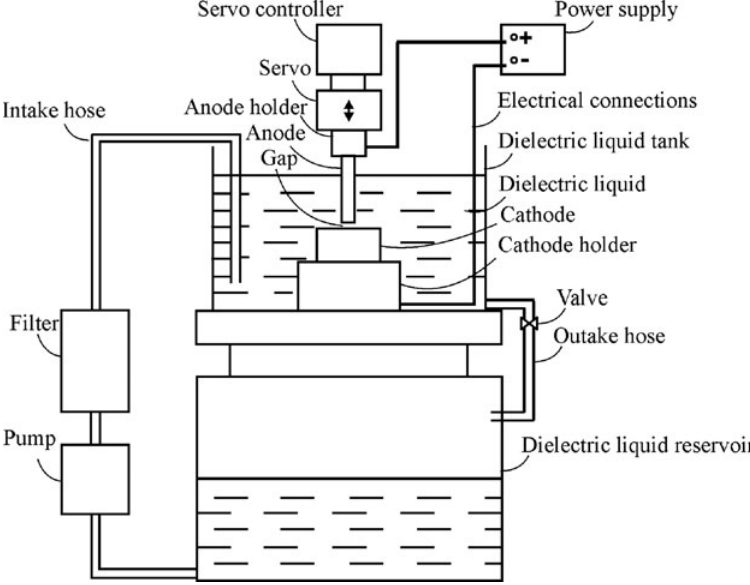
Figure 1 Schematic presentation of a sinker-type EDM